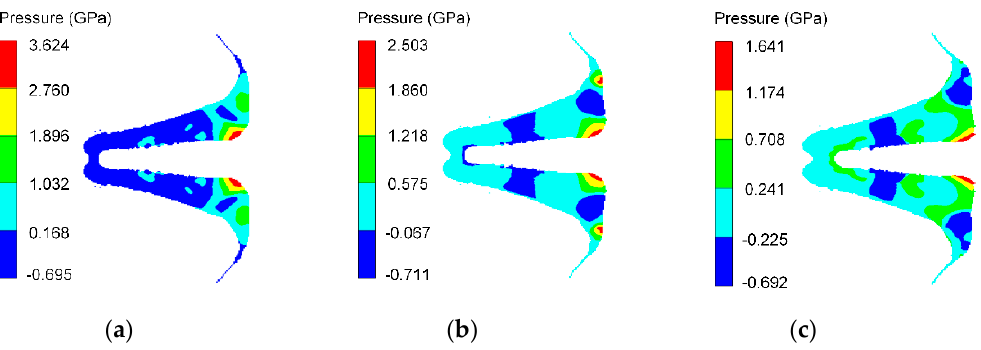
Figure 10. For different reactive liner thicknesses: ( a ) RM-CJ formation characteristics at standoff of 1.0 CD; ( b ) RM-CJ tip-velocity to time curves. Figure 11. Pressure distribution of different reactive liner thicknesses at t 0. a ) b 1 = 3 mm; ( b ) b 1 = 4 mm; ( c ) b 1 = 5 mm.